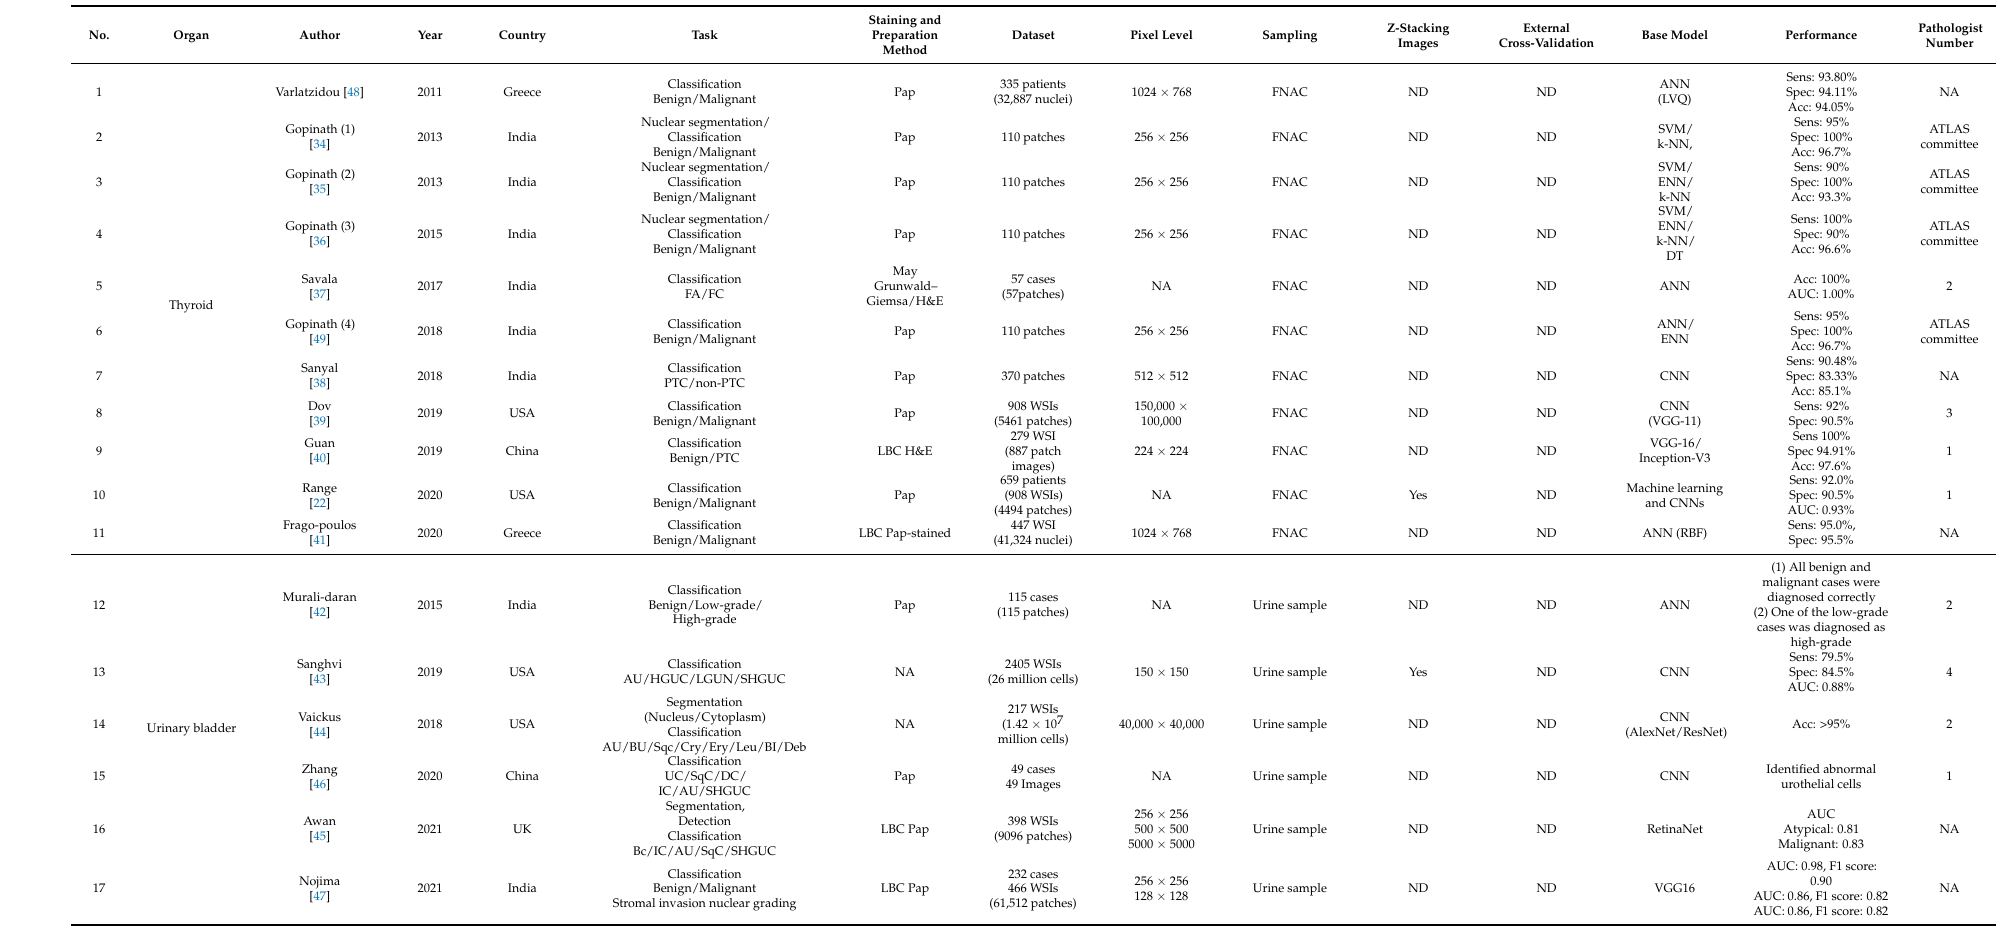
Table 1. Characteristics of the AI models according to organ types using cytological image